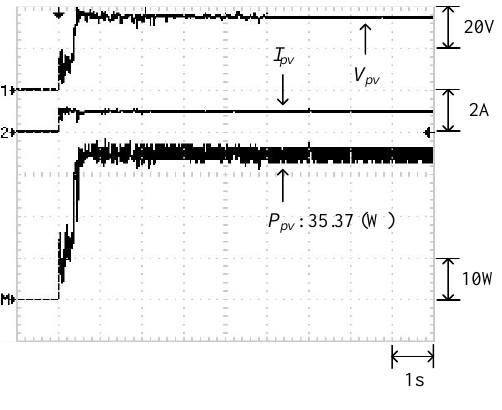
Figure 10. Maximum power point of Case 1 determined through the conventional PSO algorithm.